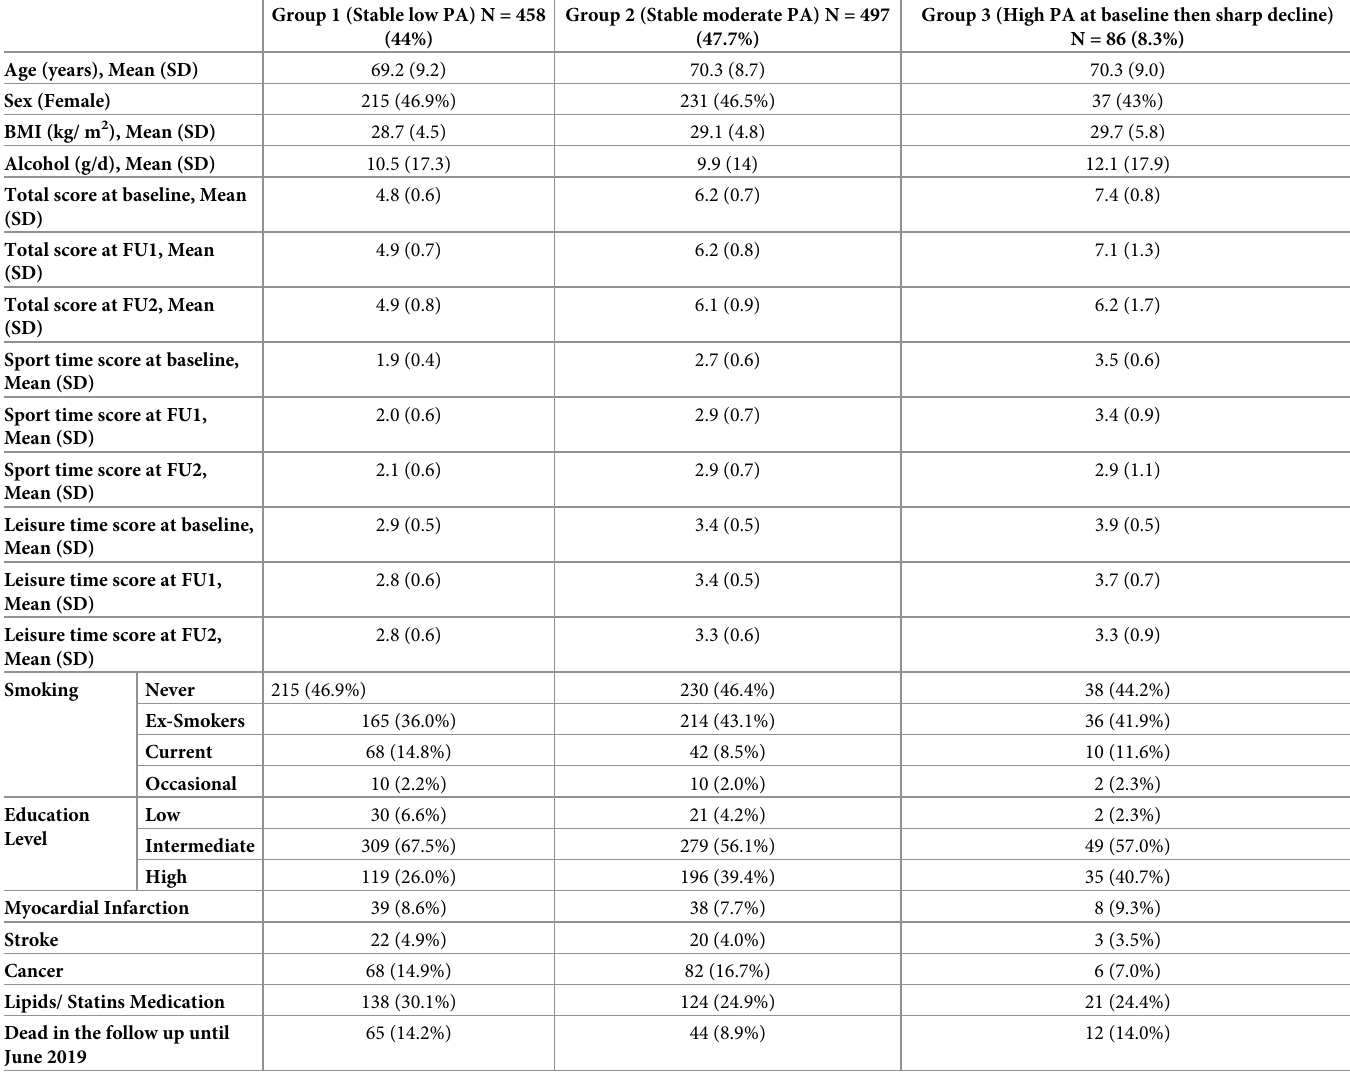
Table 1. Characteristics of PA-Trajectories of 1,041 CARLA subjects at the second FU